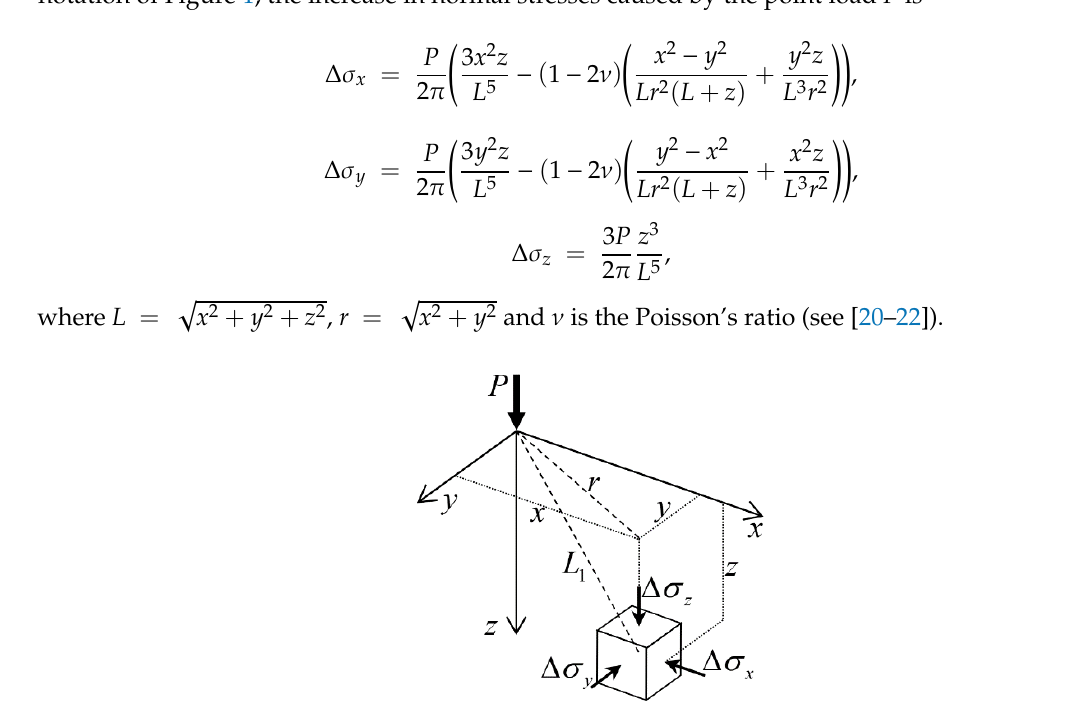
Figure 1. Stresses in an elastic medium caused by a point load acting on the surface of a semi-infinite mass [23].